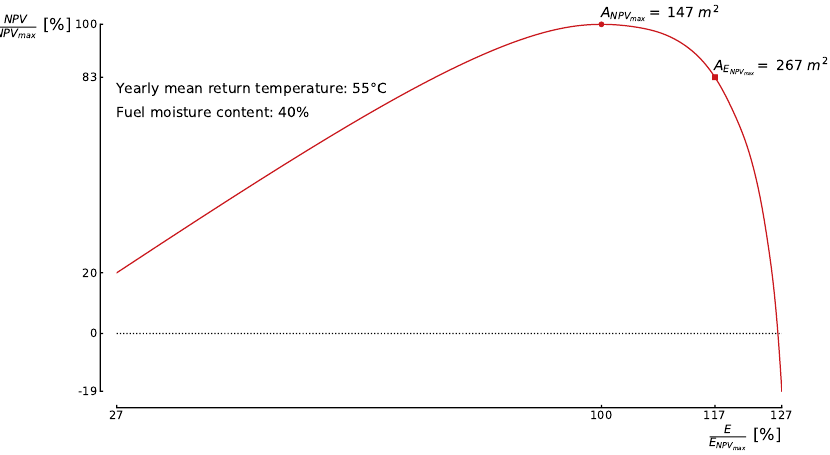
Figure 7. A comparison between the most economical designs and the optimal designs in terms of energy savings in the specific case where the yearly mean return temperature and the moisture content are 55 °C and